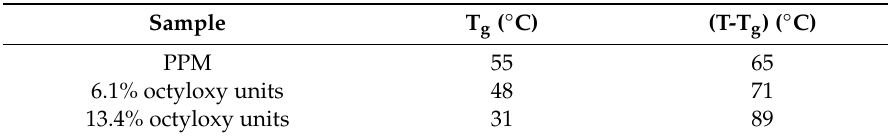
Table 2. Glass transition temperatures (T g ) and the di ff erence between the temperature T applied in rheology experiments (120 ◦ C and T g ), of PPM and copoylmers with (6.1% and 13.4% octyloxy groups, respectively.